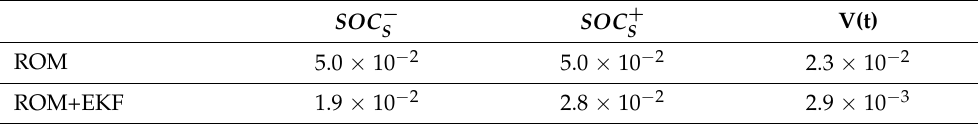
Table 2. RMSE of the internal electrochemical states obtained by the DMDc based ROM with the EKF. C − s C + s Φ − s Φ + s C e Φ e RMSE Table 3. RMSE for the macroscopic output states for the ROM without and with the EKF. V(t) SOC − SOC + S S ROM 5.0 × 10 −